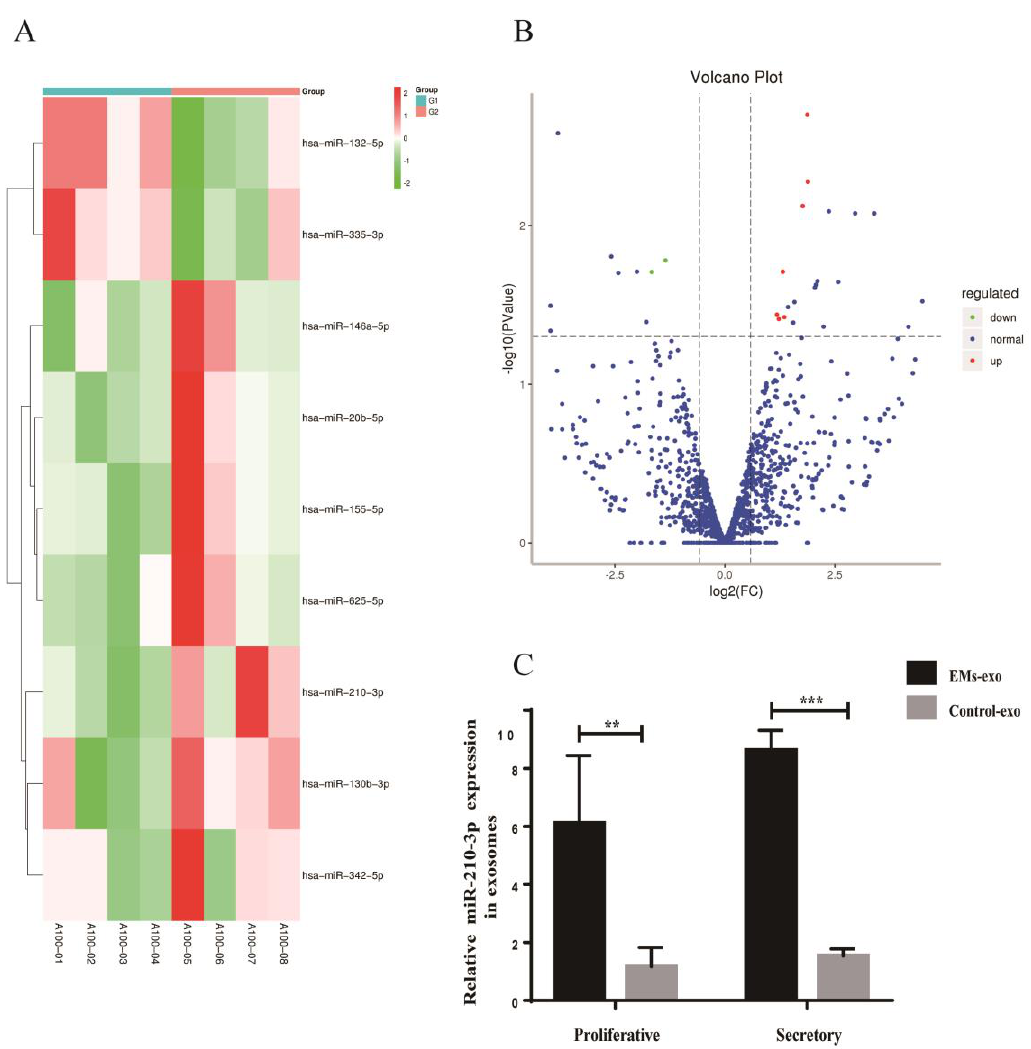
Figure 7. Differentially expressed miRNAs in exosomes of the uterine aspirate fluid. ( A ) Heatmap of the differentially expressed miRNAs in exosomes from the EMs group compared with the control. ( B ) The Volcano plot of the differentially expressed miRNAs in the exosomes from the EMs group compared with the control. The red color indicates increased expression while the green color indicates decreased expression. A100 − 01 to A100 − 04 were the control group; A100 − 05 to A100 − 08 were the EMs group. ( C ) RT-qPCR was used to verify the expression of miR-210-3p in exosomes from the EMs group and the control group. Data are expressed as the mean ± SEM (** p < 0.01, *** p < 0.001).